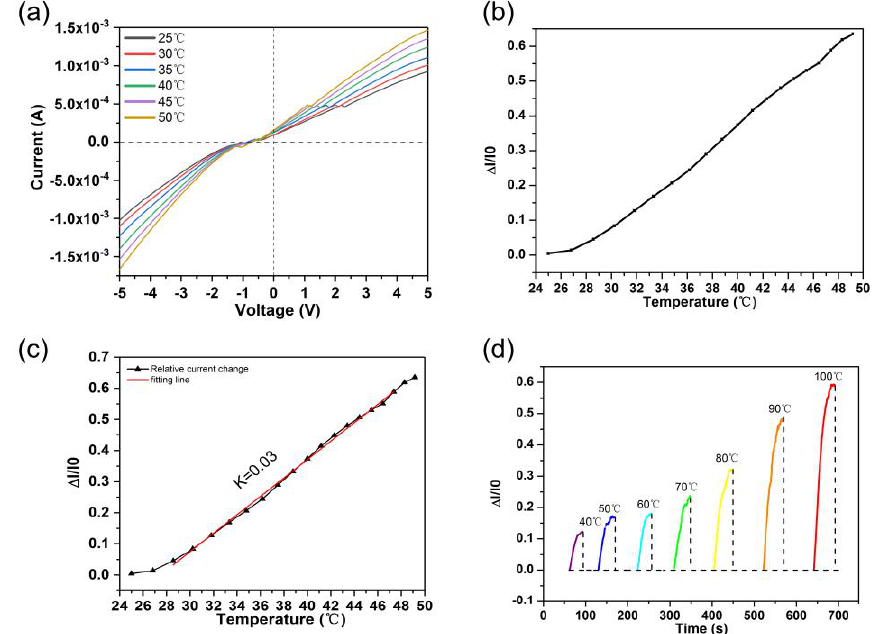
Figure 4. ( a ) Current-voltage curves at various temperatures. ( b ) Relative current change with temperature rising from 25 °C to 50 °C. ( c ) The fitting line of the relative current change with well linear change from 28 °C to 48 °C. ( d ) Current change amplitude under different temperatures.